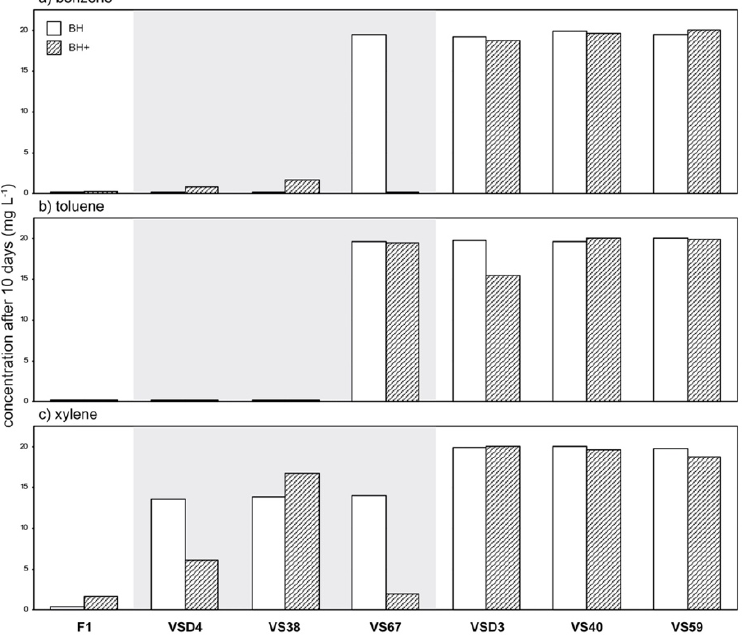
Figure 4. BTX degradation potential of phylloplane diesel fuel metabolizers. Six diesel fuel metabolizers isolated from the phylloplane of H. helix growing at an air-polluted environment were further analyzed by headspace GC–MS for their potential to degrade benzene ( a ), toluene ( b ), and xylene ( c )